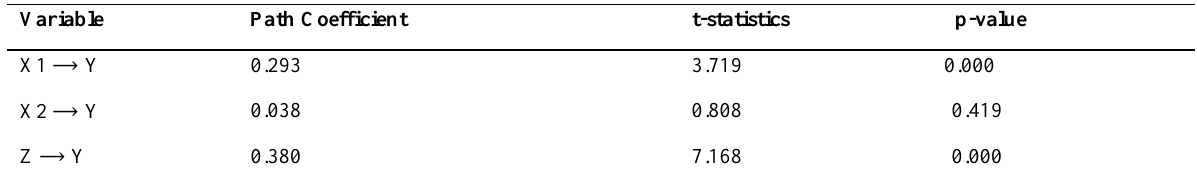
Table 4: Hypothesis Test Results